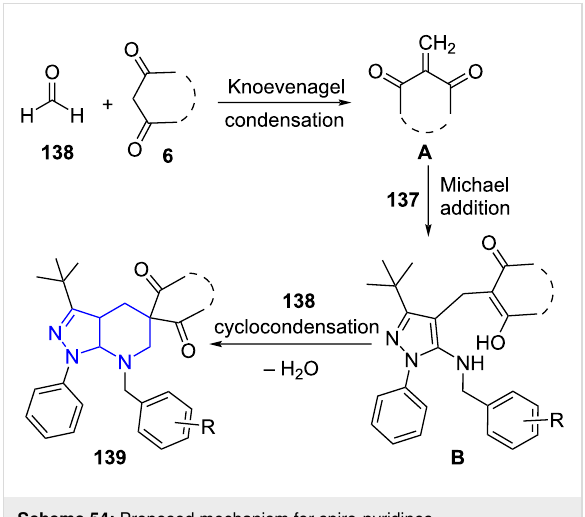
Scheme 54: Proposed mechanism for